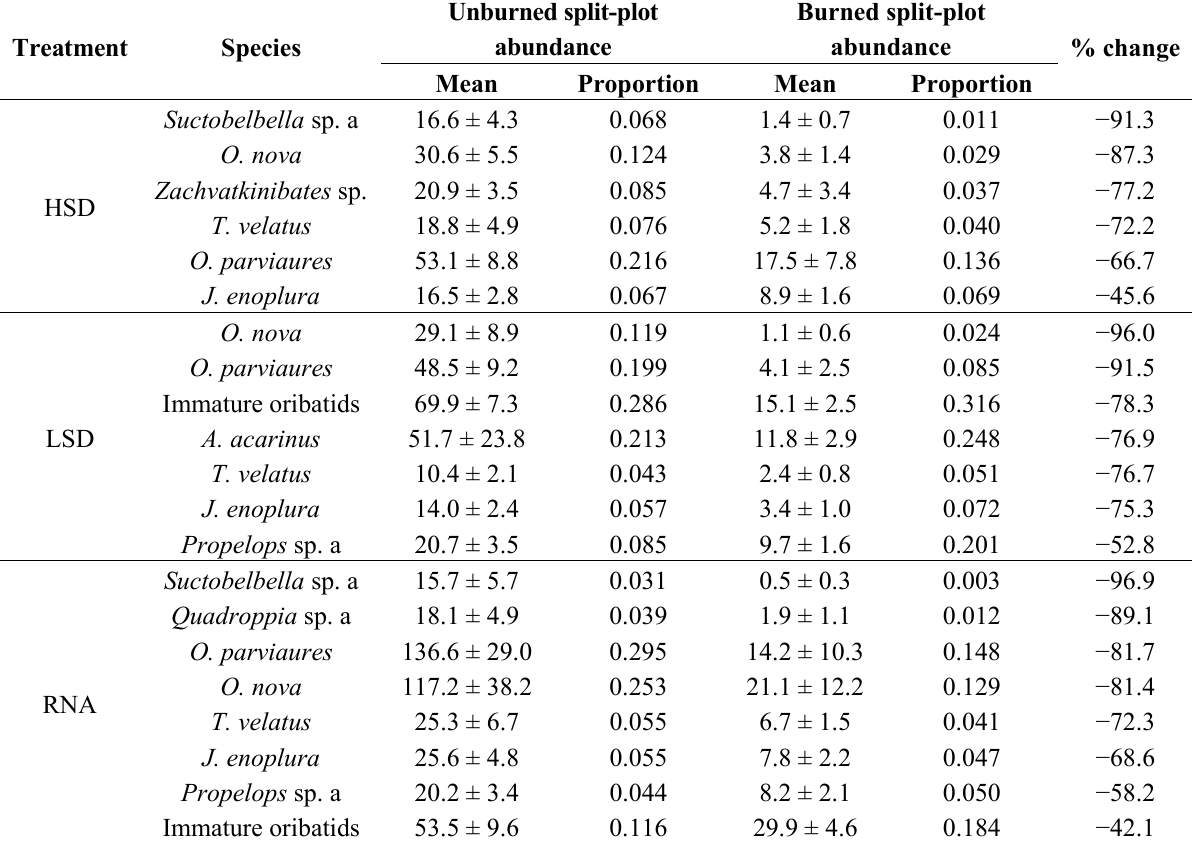
Table 2. The effects of prescribed fire on the most numerically dominant oribatid species (and immatures) in each of the stand structural treatments, with the three sample dates pooled. Number of samples ( n ) was: (1) HSD unburned split-plots, n = 120; (2) HSD burned split-plots, n = 120; (3) LSD unburned split-plots, n = 120; (4) LSD burned split-plots, n = 120; (5) RNA unburned plot, n = 60; (6) RNA burned plot, n = 60. Mean values represent the mean abundance per sample ± SE. Proportion refers to the proportional abundance of each species in the total sample for each structural treatment in the pooled unburned and burned split-plots. Percent change following prescribed fire is relative to the pooled samples for each